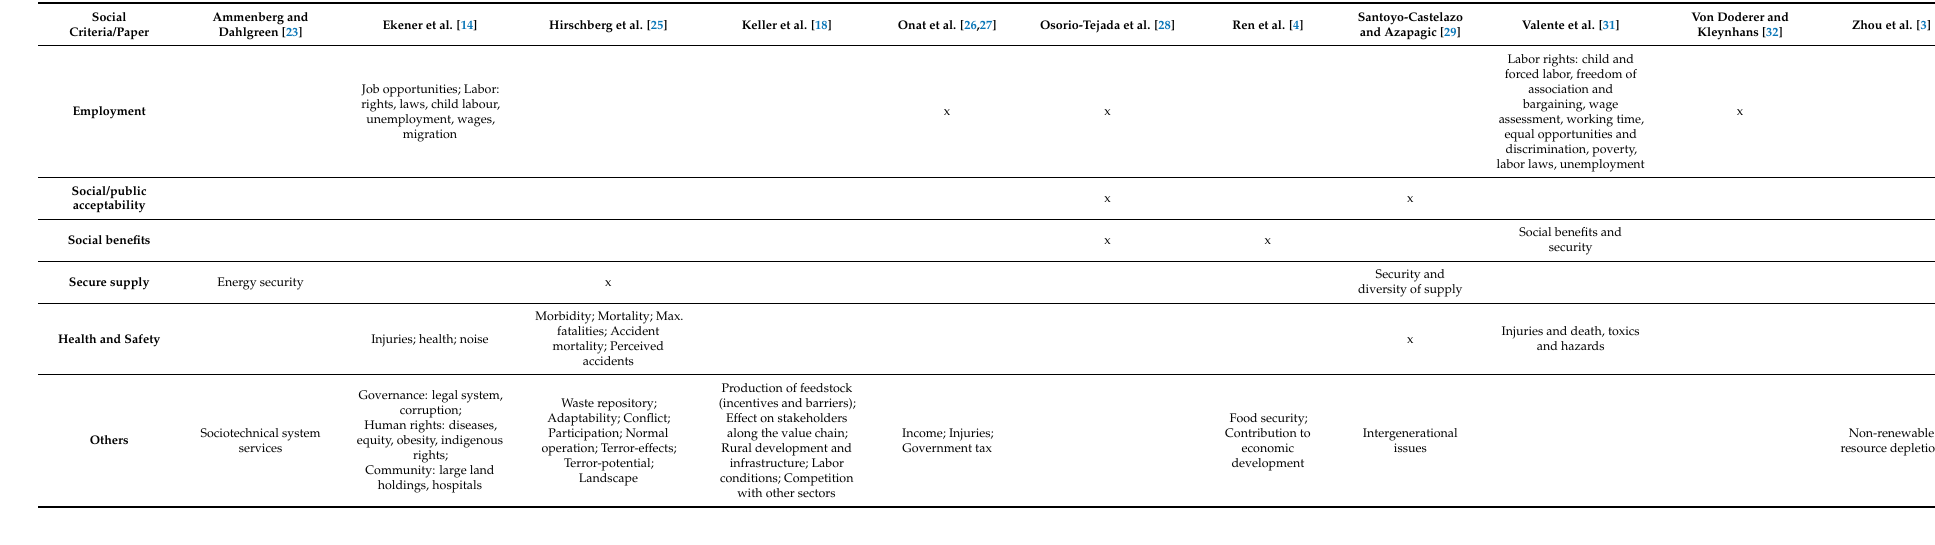
Table A3. Social criteria used in LCSA-related papers.